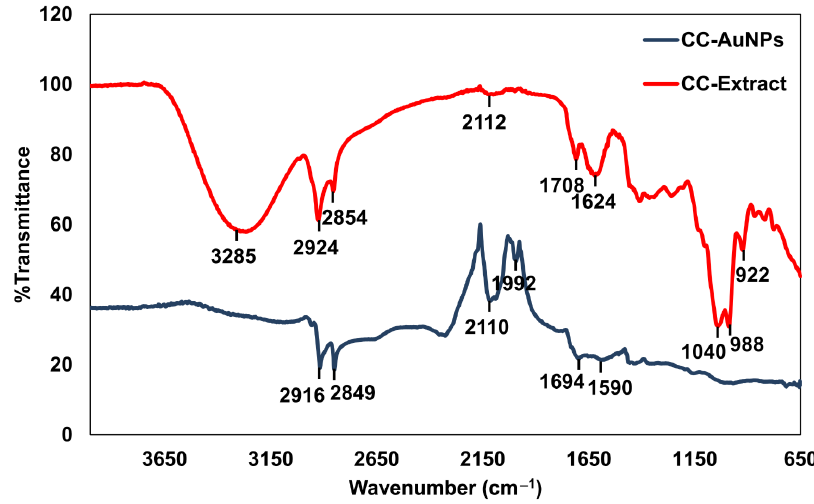
Figure 5. The FT-IR spectra for the C. caspius plant extract and biosynthesized AuNPs.